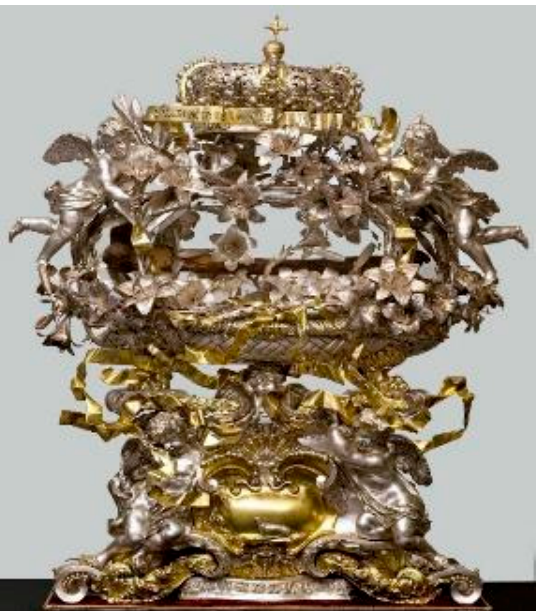
Figure 11. Massimo Soldani Benzi and Grand Ducal Galleria , Reliquary of St. Kazimierz Jagiello´nczyk, 1687–1688. Museo delle Cappelle Medicee, Church of San Lorenzo, Florence. Image in the public domain.